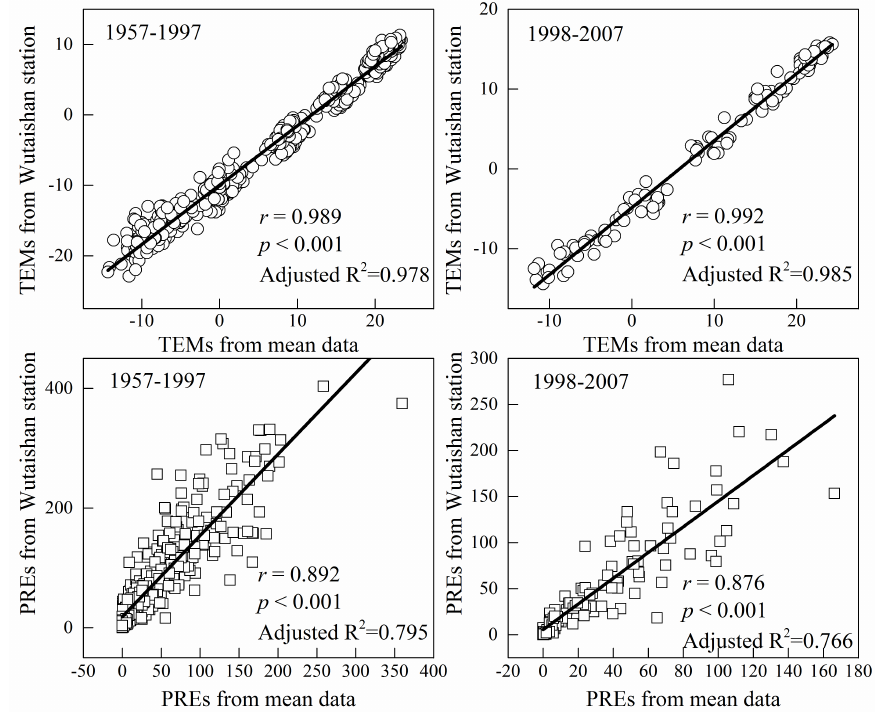
Figure 2. The relationship of monthly mean temperature (TEM) and total monthly precipitation (PRE) data from Wutaishan station and mean data from the other three stations (Hequ, Wuzhai and Yuanping), during the periods 1957–1997 and